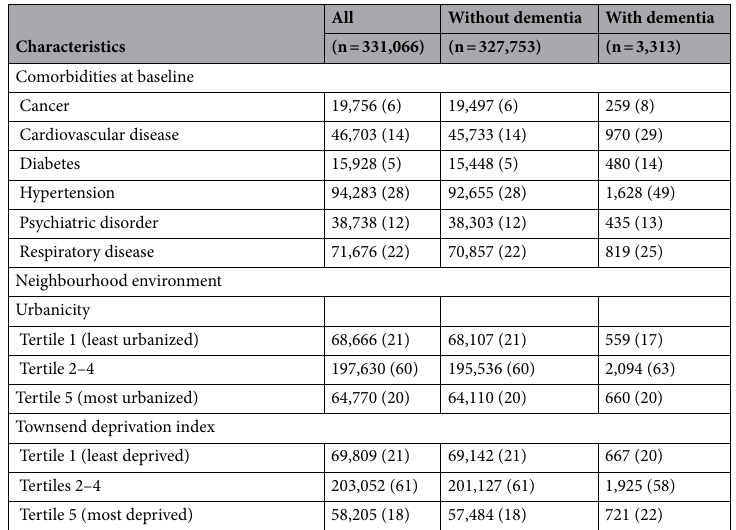
Table 1. Baseline characteristics of UK Biobank target sample (N = 331,066) according to dementia status. Values are numbers (percentage) unless stated otherwise. a Obese is defined as waist–hip ratio (WHR) ≥ 0.90 cm for men or ≥ 0.85 cm for women. Non-obese is defined as WHR < 0.90 cm for men or < 0.85 cm for women. b Leucocyte telomere length was Z-standardised, log transformed and adjusted for technical